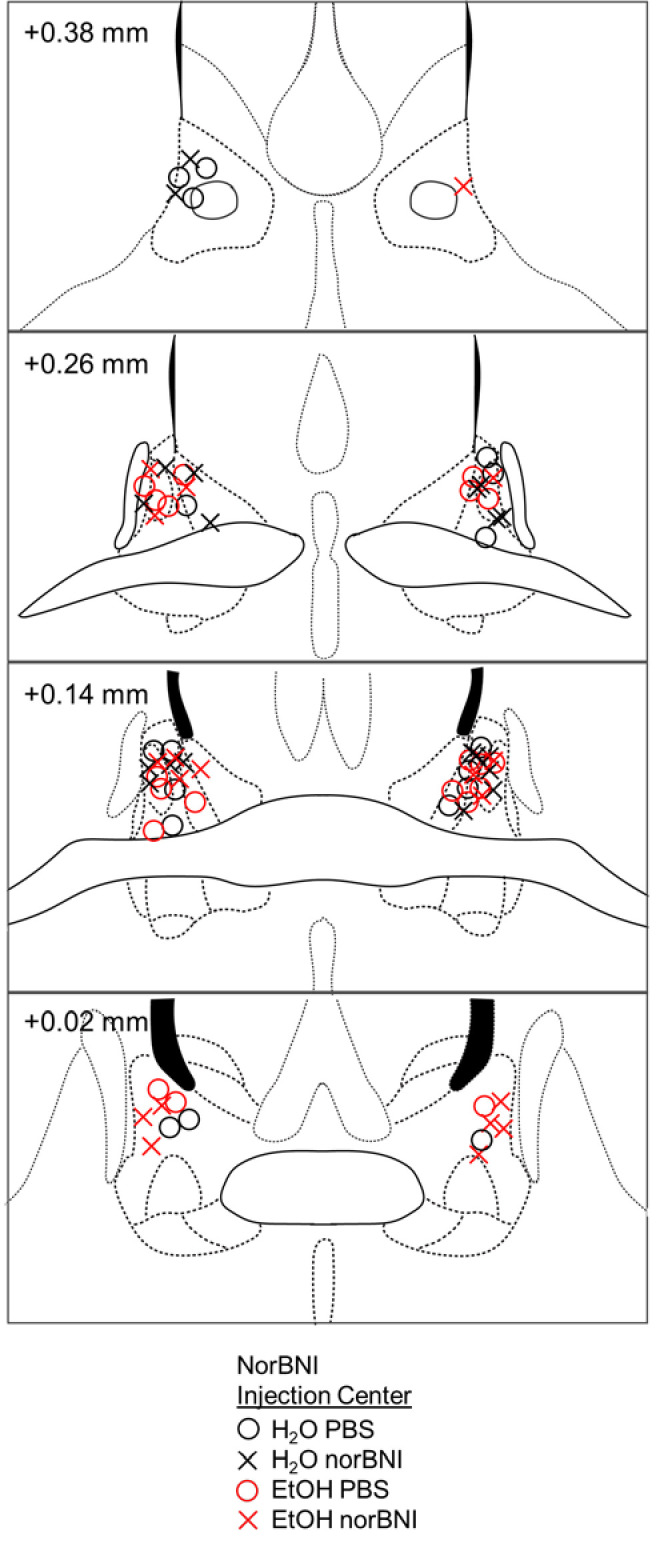
Histological verification of stereotaxic injections in male mice.Correct placements of a single norBNI or PBS infusion are shown in coronal sections in millimeters from bregma surrounding the BNST of C57BL/6J mice. Circles represent the injection center of PBS, and crosses represent norBNI. Both groups had 10 nl GFP to mark the injection site.